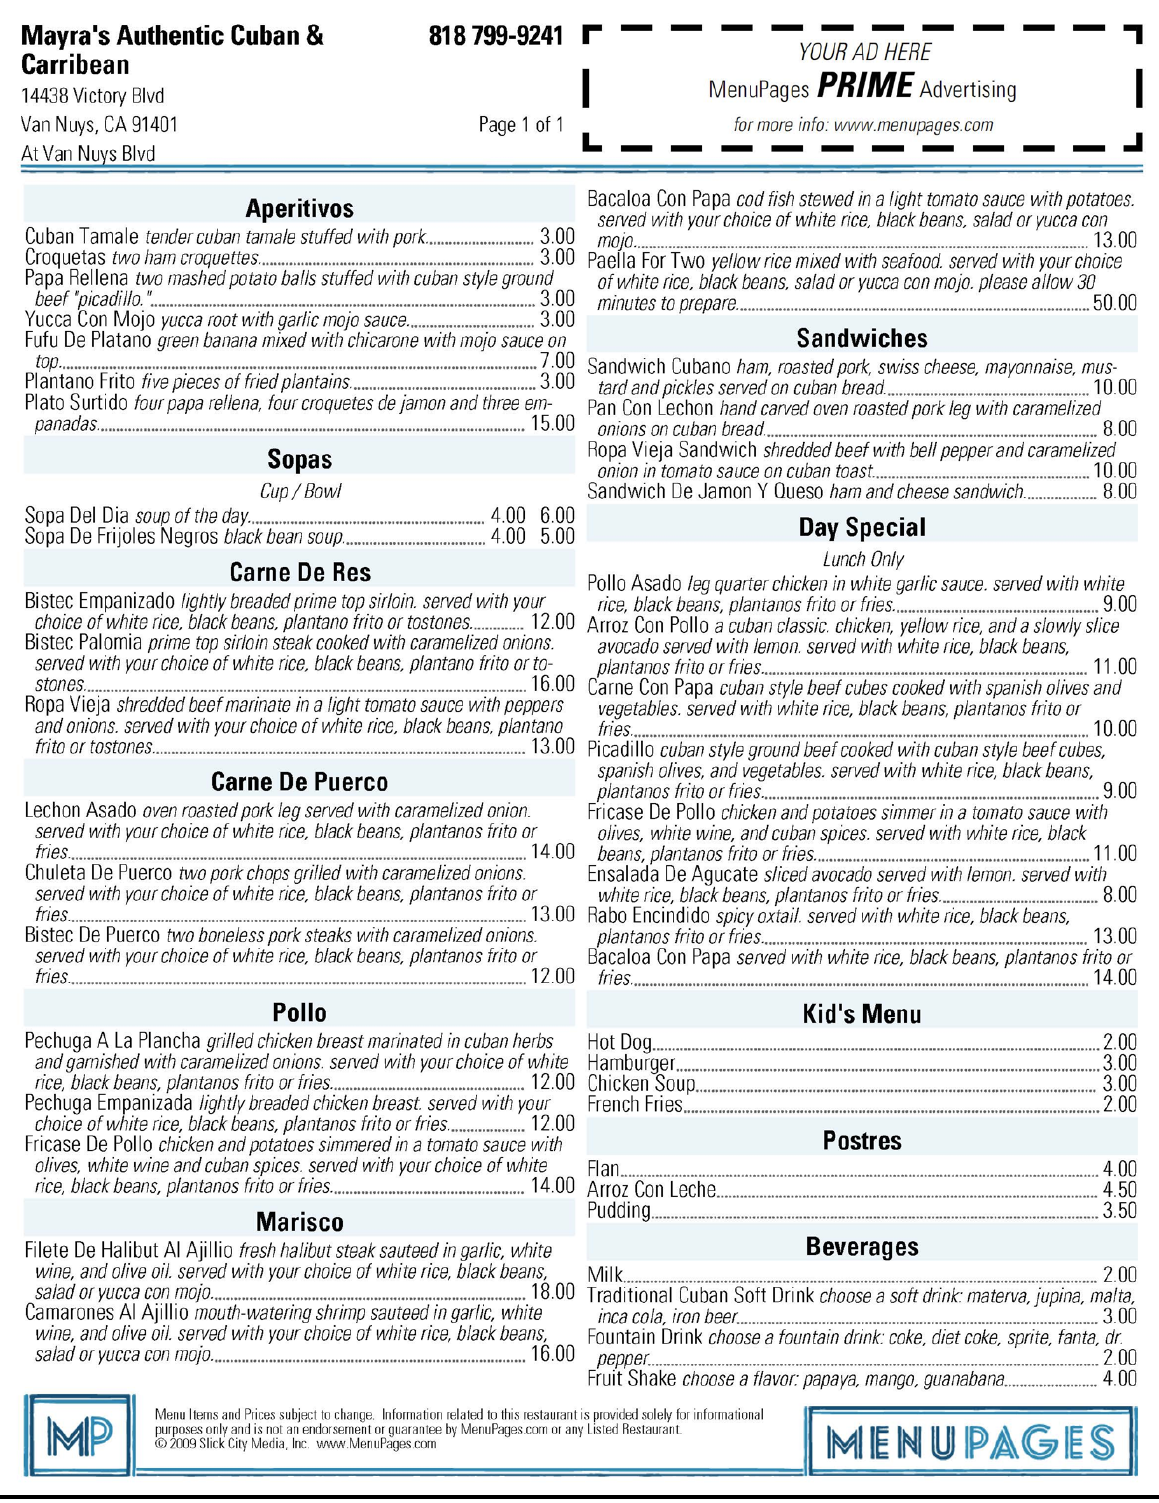
Figure 1: Snippet from the menu of Mayra’s Authentic Cuban & Carribean ( sic ). sociological science | www.sociologicalscience.com